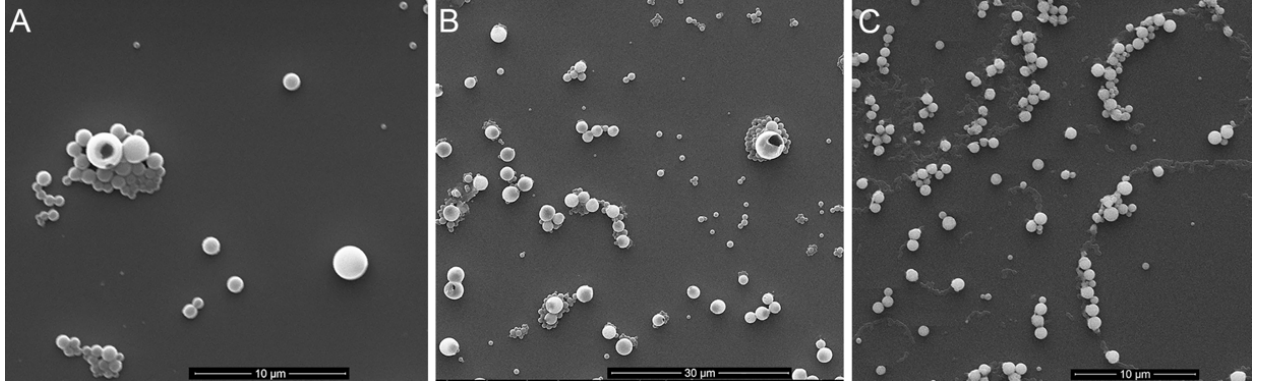
Figure 3. Scanning electron micrographs showing LNPs made from: ( A ) birch BioLignin™ (286 nm diameter; 18 kV; 5000× magnification); ( B ) wheat BioLignin™ (282 nm diameter; 18 kV; 1975× magnification); ( C ) Poplar TGA lignin (322 nm diameter; 10 kV; 4000× magnification). The scale bars in the bottom of the images indicate the size.